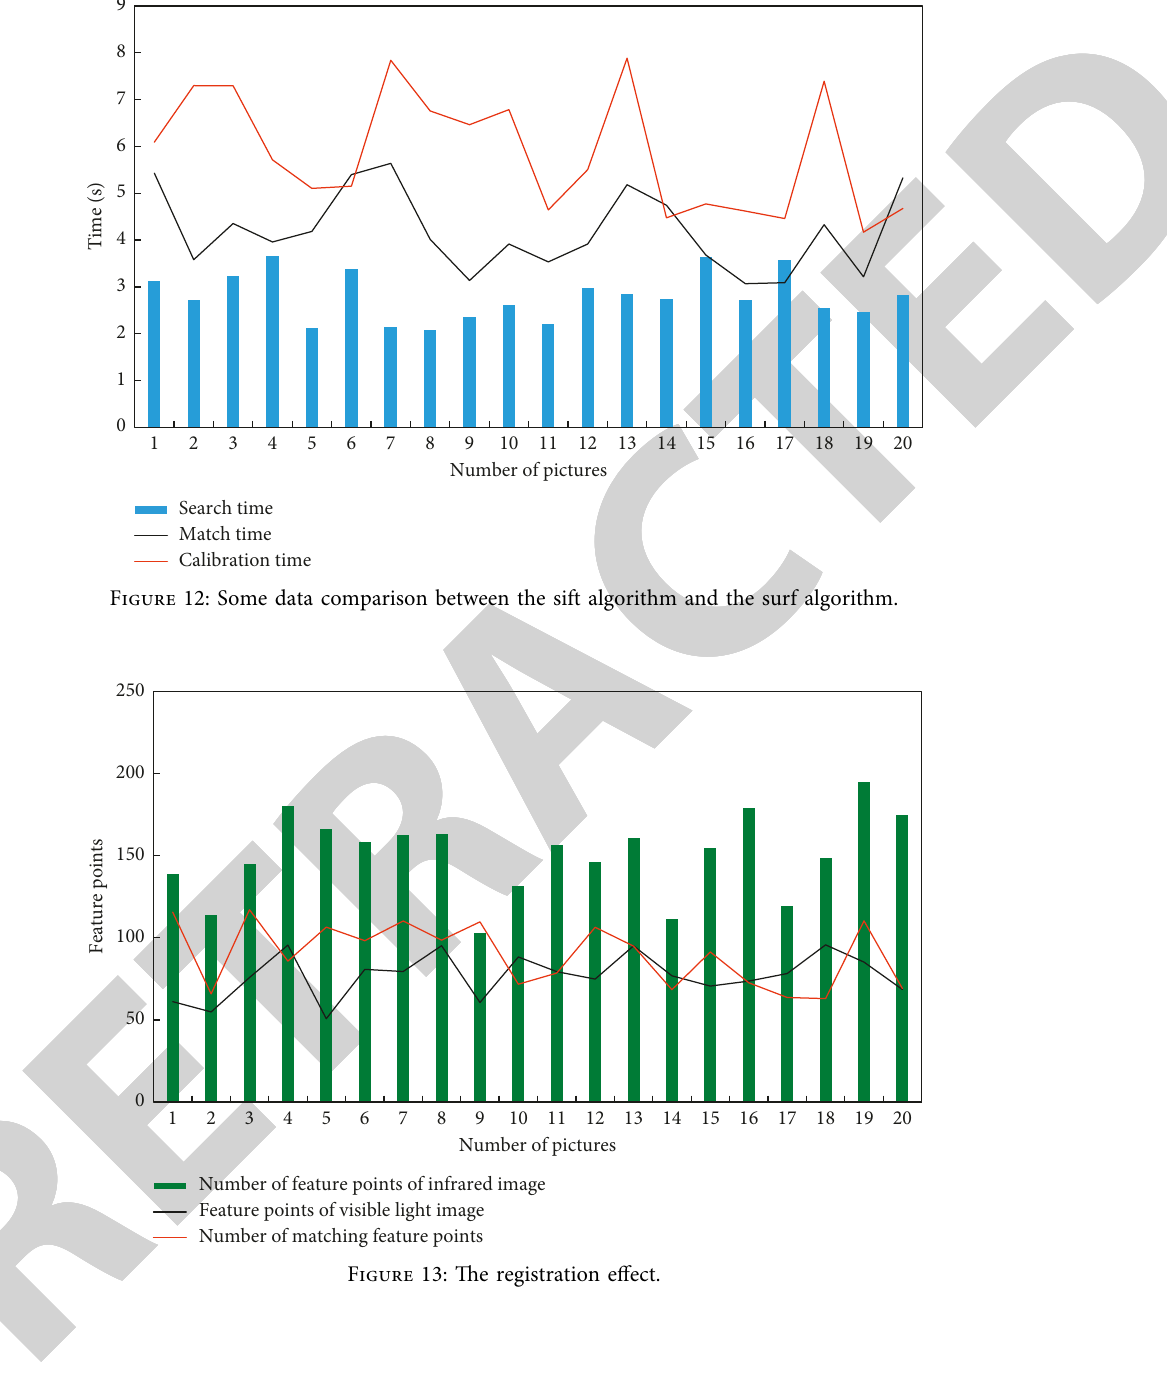
Figure 13: The registration effect.